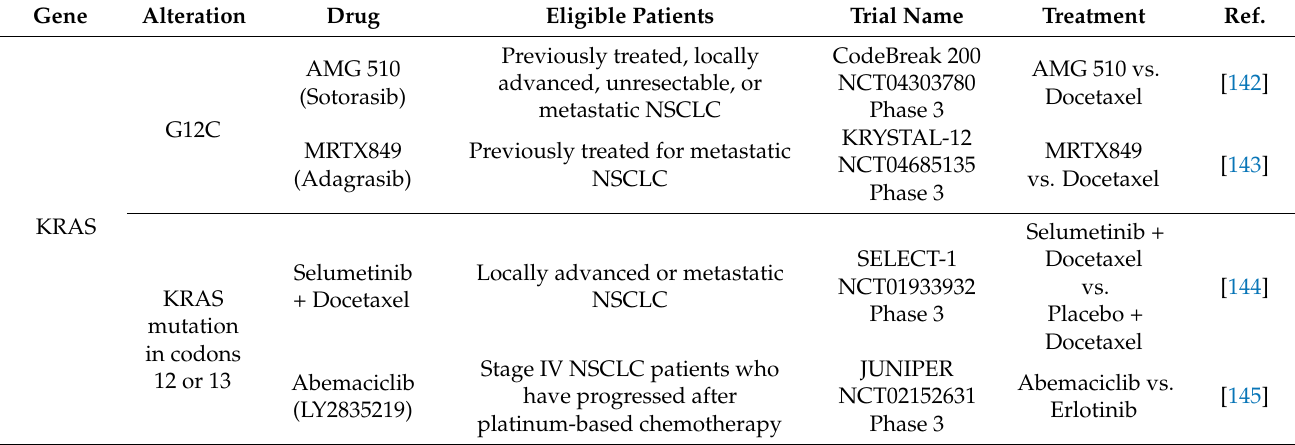
Table 3. Summary of ongoing clinical trials for novel predictive biomarkers for targeted therapy.